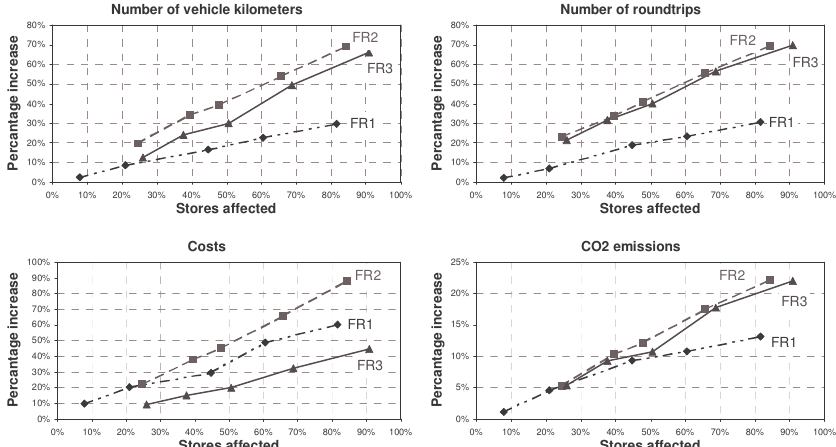
Figure 9. Values for all retailers and the 18 tons weight restriction